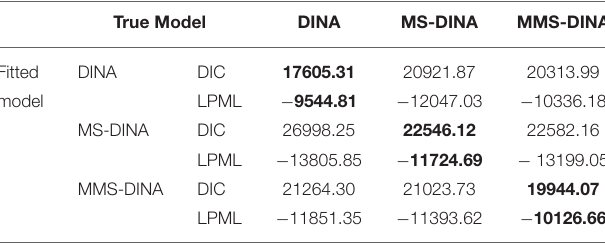
TABLE 6 | The results of Bayesian model assessment in simulation 4.